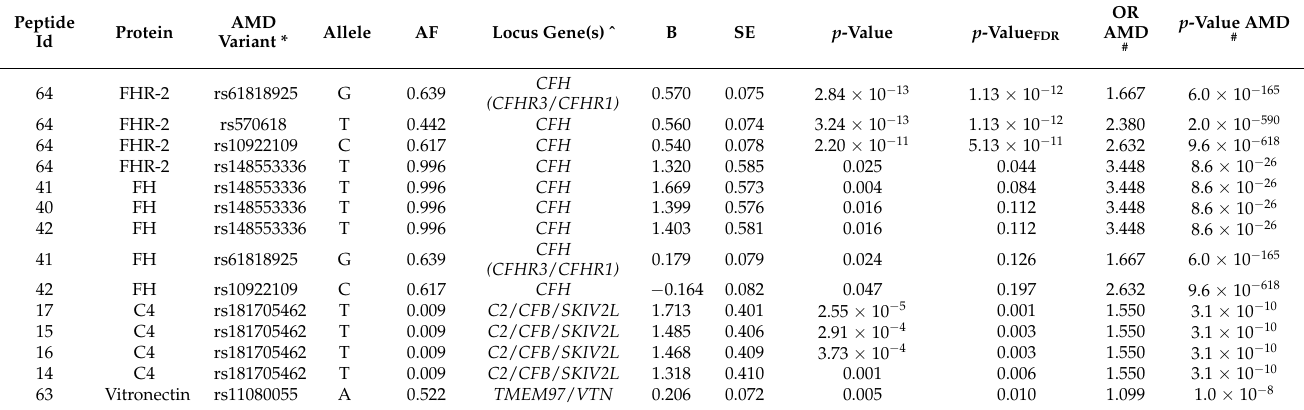
Table 3. Cis-acting effects of AMD-associated genetic variants on complement peptide levels. Complement protein levels in the locus of each known AMD variant were tested for association with each known AMD variant separately. Alleles were chosen for the risk increasing effect.